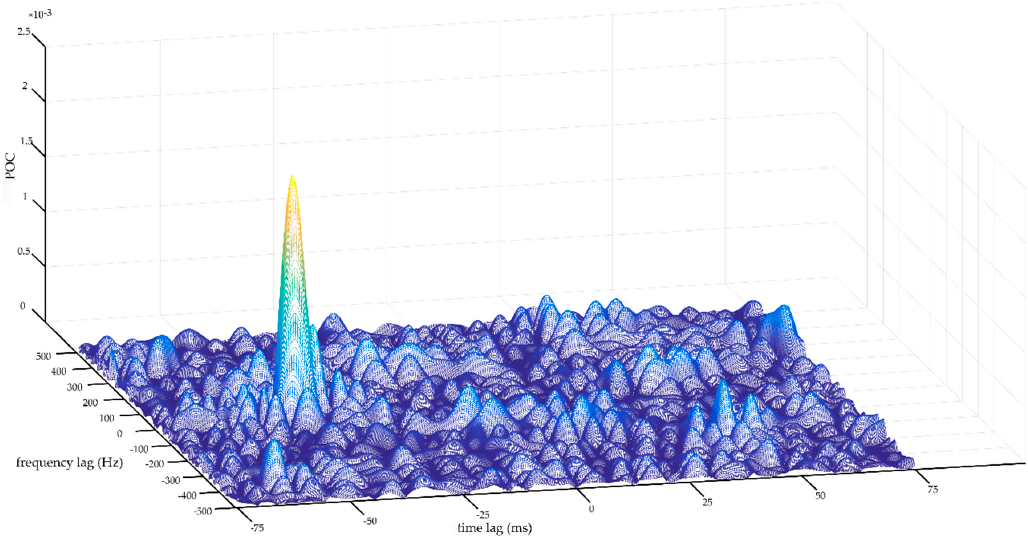
Figure 4. The POC of the first trace and the fourth trace. The peak value of the POC is located in − 45 of the time lag axis.